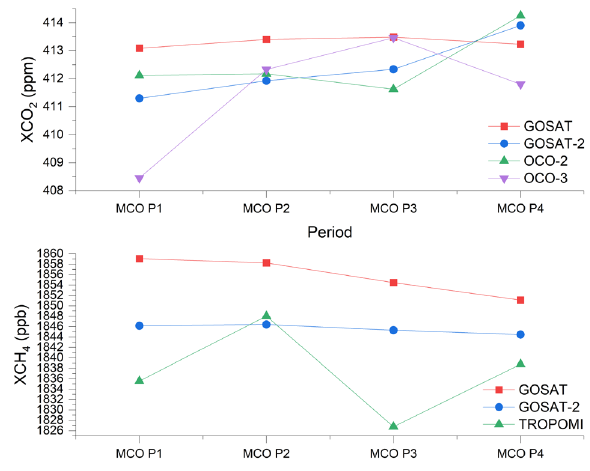
Figure 4. Average XCO 2 and XCH 4 during MCO.